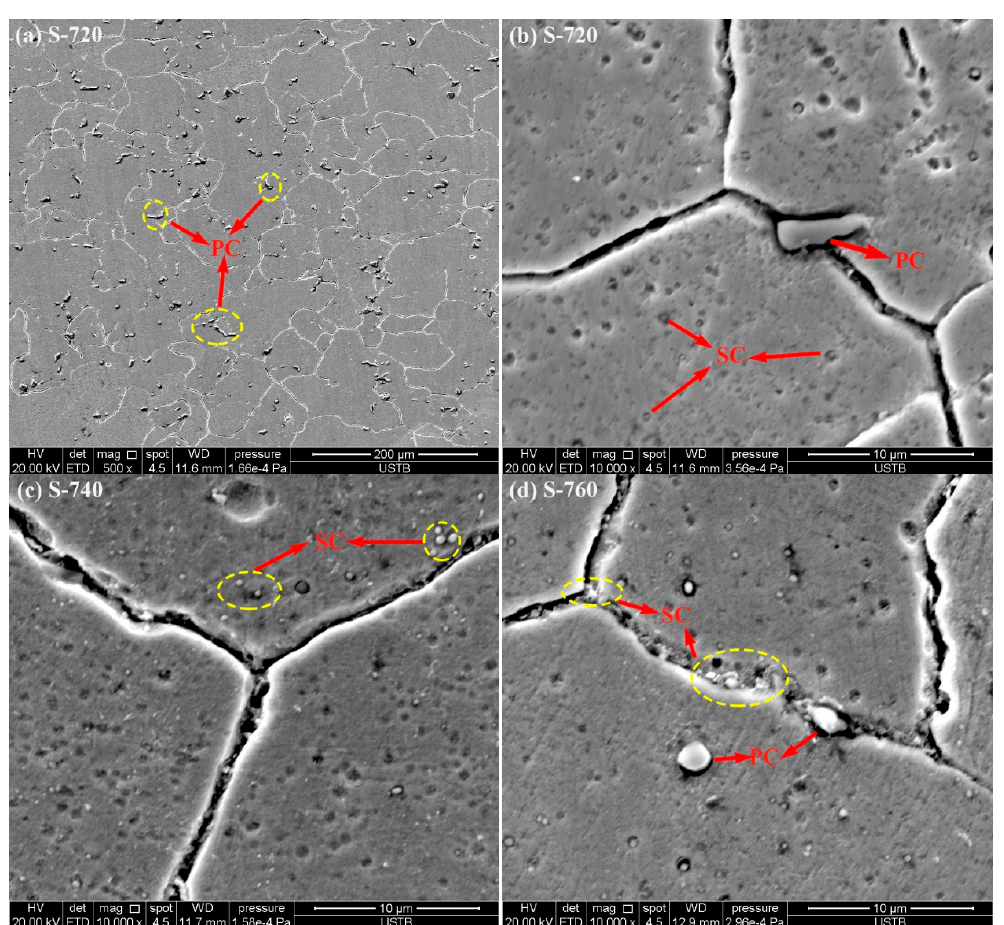
Figure 12. SEM microstructure of specimens after different aging heat treatment processes: ( a , b ) S-720, ( c ) S-740, ( d ) S-760. Note: PC represents primary precipitates. SC represents secondary precipitates.